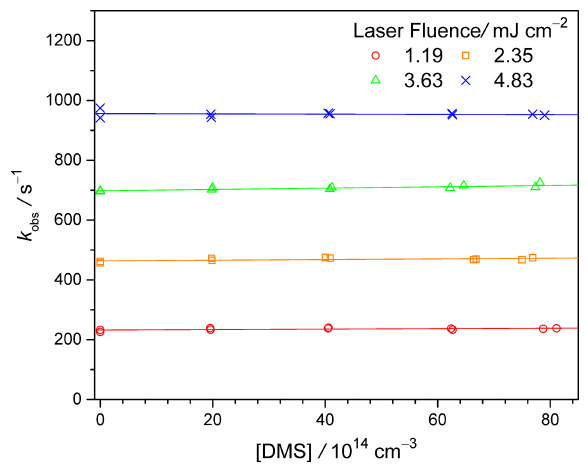
Figure 2. k obs of CH 2 OO against [DMS] determined from exper- iments (Exp#1–4, Table S1) at different photolysis laser fluences I 308 nm ; solid lines are linear fits. For each data point, the error of the single exponential fitting is less than 1% (thus not